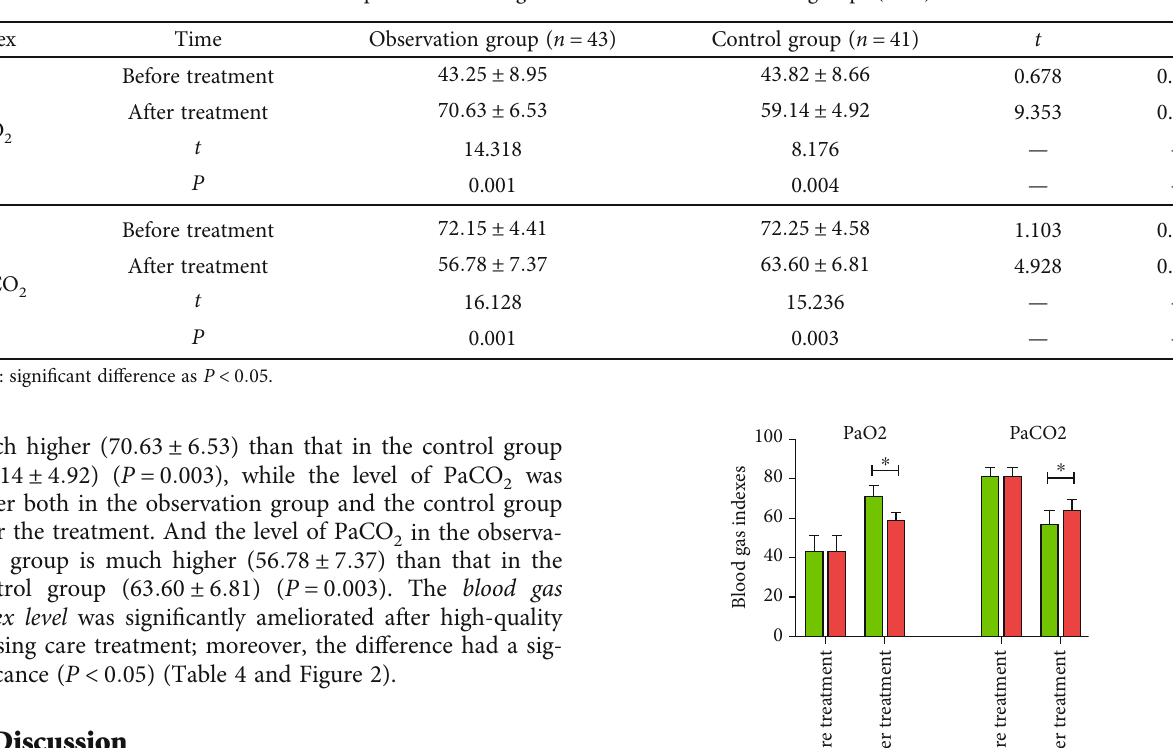
Table 4: Comparison of blood gas index level between the two groups ( (cid:2) x ± s ).